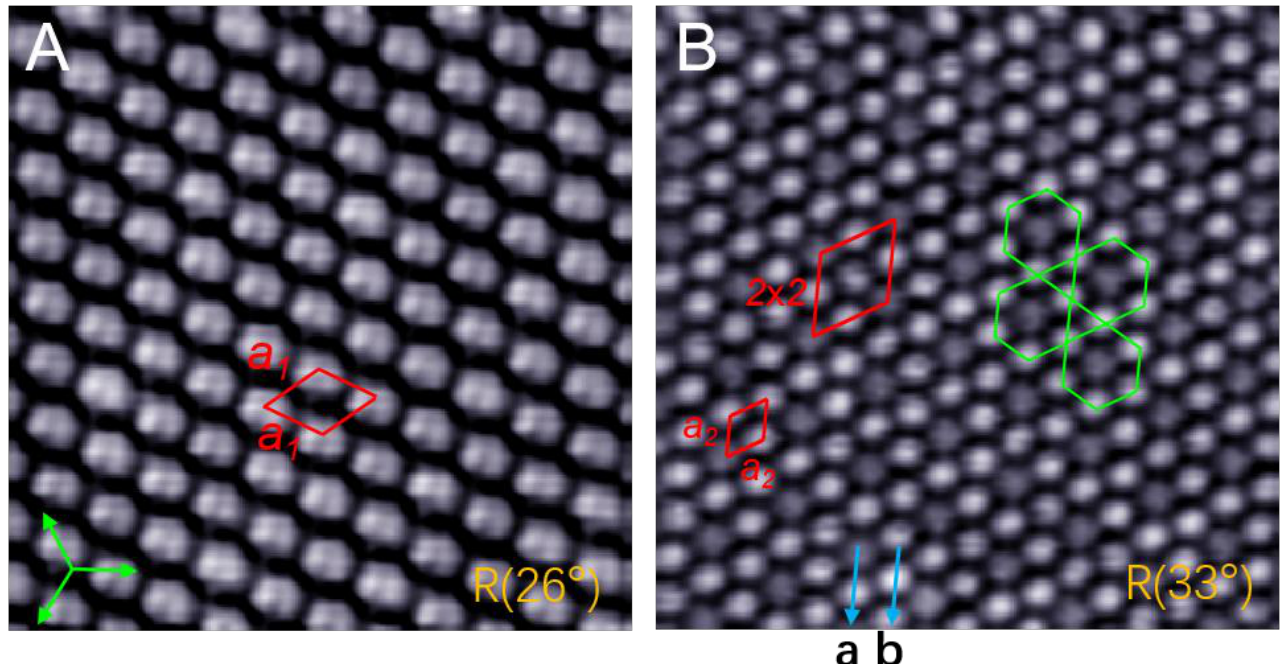
Figure 4. Two regular domains were obtained by deposition at room temperature. ( A ) Homogeneous orientation of C 60 molecules in a R26 ◦ domain, 1.2 V, 10 × 10 nm. ( B ) The symmetric kagome lattice which is marked by hexagons in green reveals a 2 × 2 superstructure in an R33 ◦ domain, 2.0 V, 15 × 15 nm. Arrow b represents the molecular rows with bright molecules, and arrow a represents the rows with one bright and one dim molecules alternately arranged.